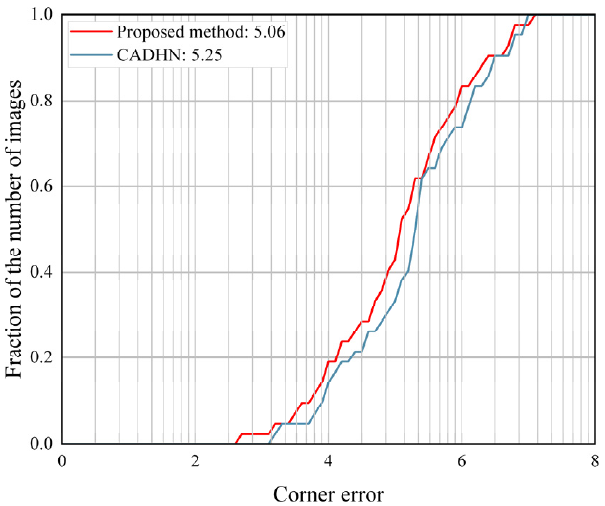
Figure 11. Quantitative comparison of HomoMGAN with deep learning-based methods on synthetic benchmark dataset.